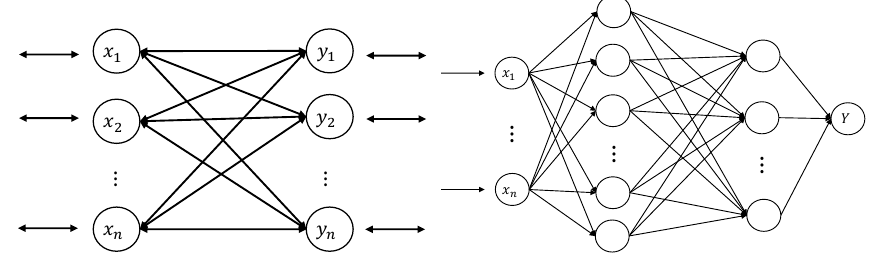
Figure 1. The construction of BAM neural networks ( left ) and fuzzy min-max neural networks ( right